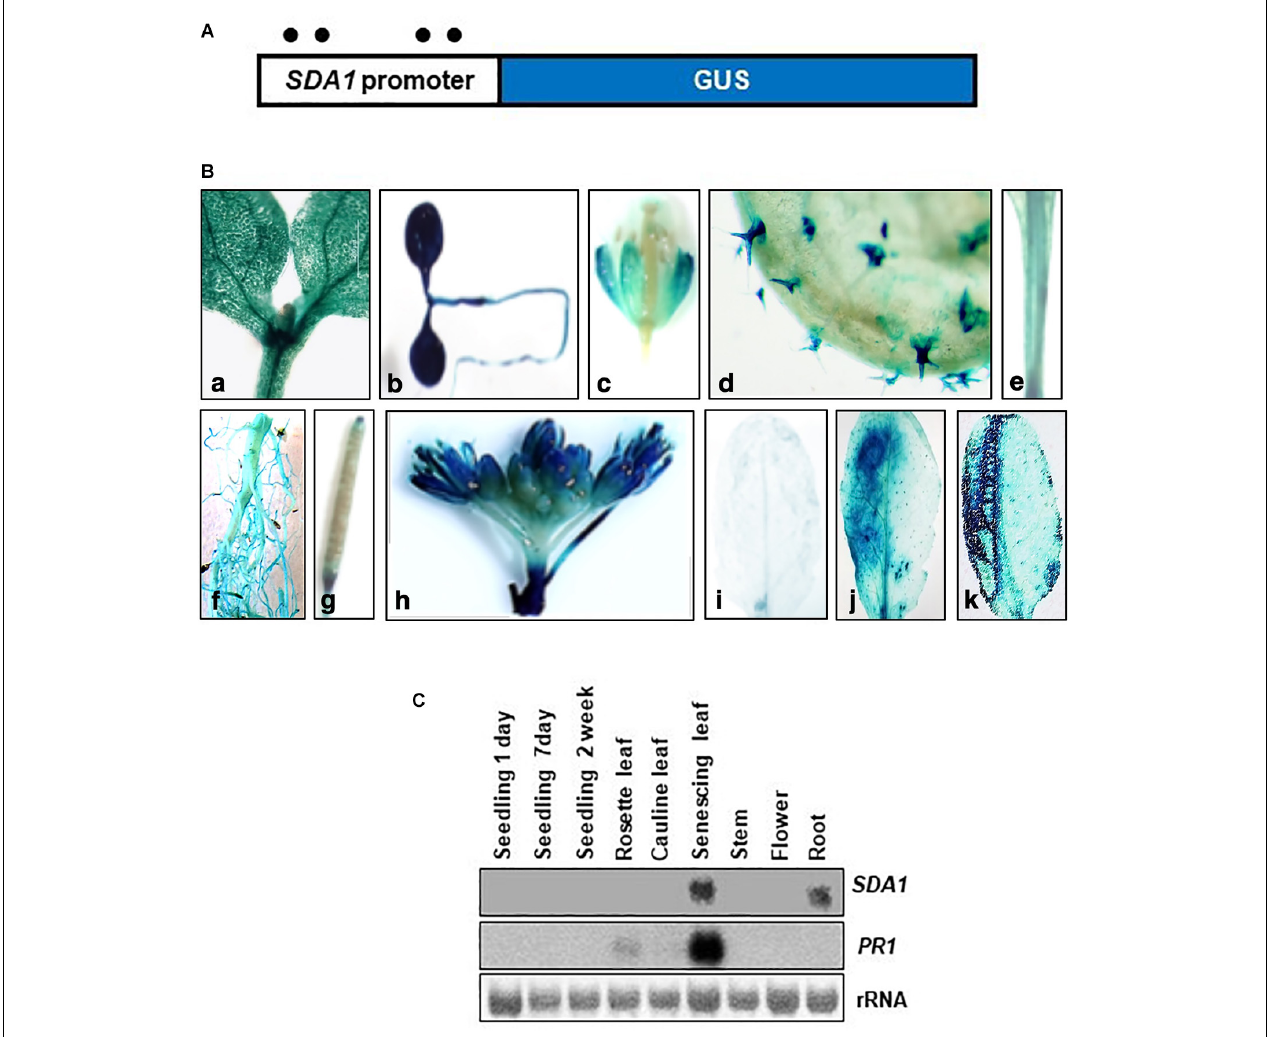
FIGURE 5 | Histochemical analysis of GUS expression in transgenic plants expressing the SDA1 promoter ::GUS construct. (A) Schematic representation of the SDA1 promoter ::GUS fusion construct. A 2 kb promoter region of the SDA1 gene was used to drive expression of the GUS gene. Filled circles show position of W-boxes. (B) GUS expression in transgenic plants expressing the SDA1 promoter ::GUS: (a,b) 10-day old seedling, (c) flower, (d) trichome, (e) stem, (f) root, (g) silique, (h) inflorescence, (i) untreated rosette leaf, (j) rosette leaf inoculated (left half) with Pst DC3000 at titer of 5 × 10 7 cfu/mL, (k) rosette leaves wounded (left half with serrated forceps). This analysis was carried out in five to seven independent transgenic lines and similar results were observed. (C) Northern gel blot analysis was employed to determine transcript levels of SDA1 in indicated tissue samples. Blot was stained with methylene blue to show the relative amounts of RNA in each lane (rRNA) and was hybridized with indicated gene